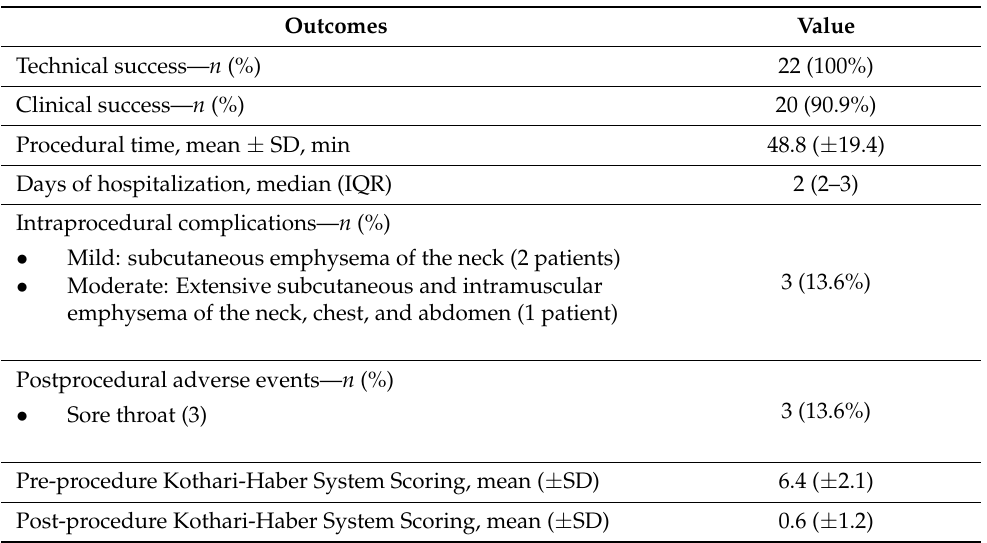
Table 3. Technical and clinical outcomes of the Zenker’s peroral endoscopic myotomy